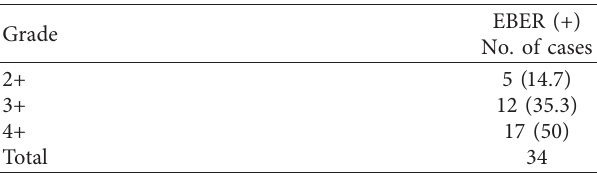
Table 2: Grade distribution of patients with EBER-positive SGC of the eyelid.